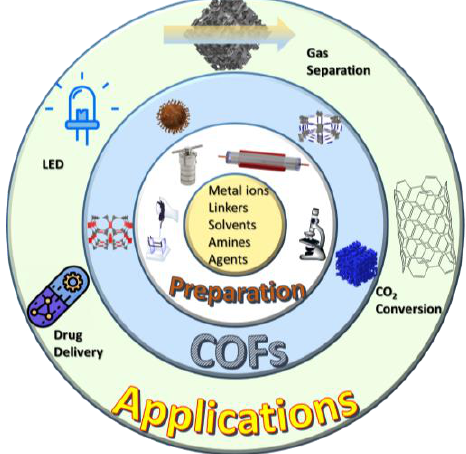
Figure 1. The overview of the prepare approaches of COFs and their